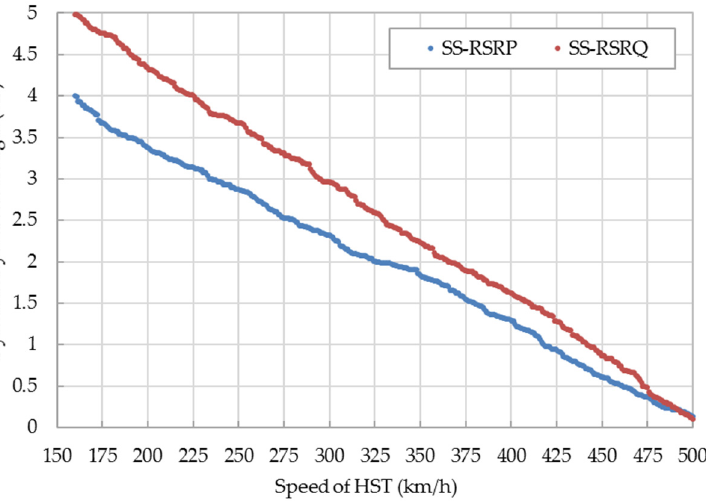
Figure 8. Relationship between the dynamic hysteresis margin of SS-RSRP/SS-RSRQ and the speed of the high-speed train (HST).